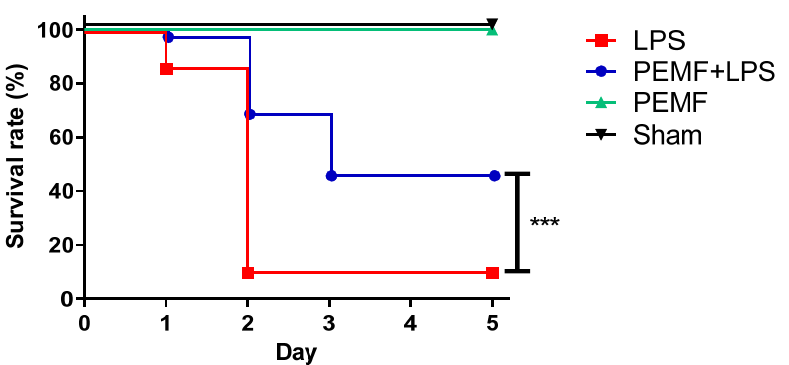
Figure 2. Survival curve of mice in LPS-induced septic shock. Kaplan–Meier curves depicting survival of each experimental group. Mice in the PEMF + LPS group were intraperitoneally injected with LPS (15 mg/kg) dissolved in PBS. Mice in the LPS group were injected with LPS (15 mg/kg) only. Mice in the PEMF group were injected with PBS only. Mice in the sham group were injected with PBS only. All mice were exposed to PEMF for up to 5 days. The data were pooled from 3 independent experiments. PEMF + LPS group, n = 35 mice; LPS group, n = 37 mice; PEMF group, n = 10 mice; sham group, n = 10 mice. *** p < 0.001, Mantel–Cox log-rank test.